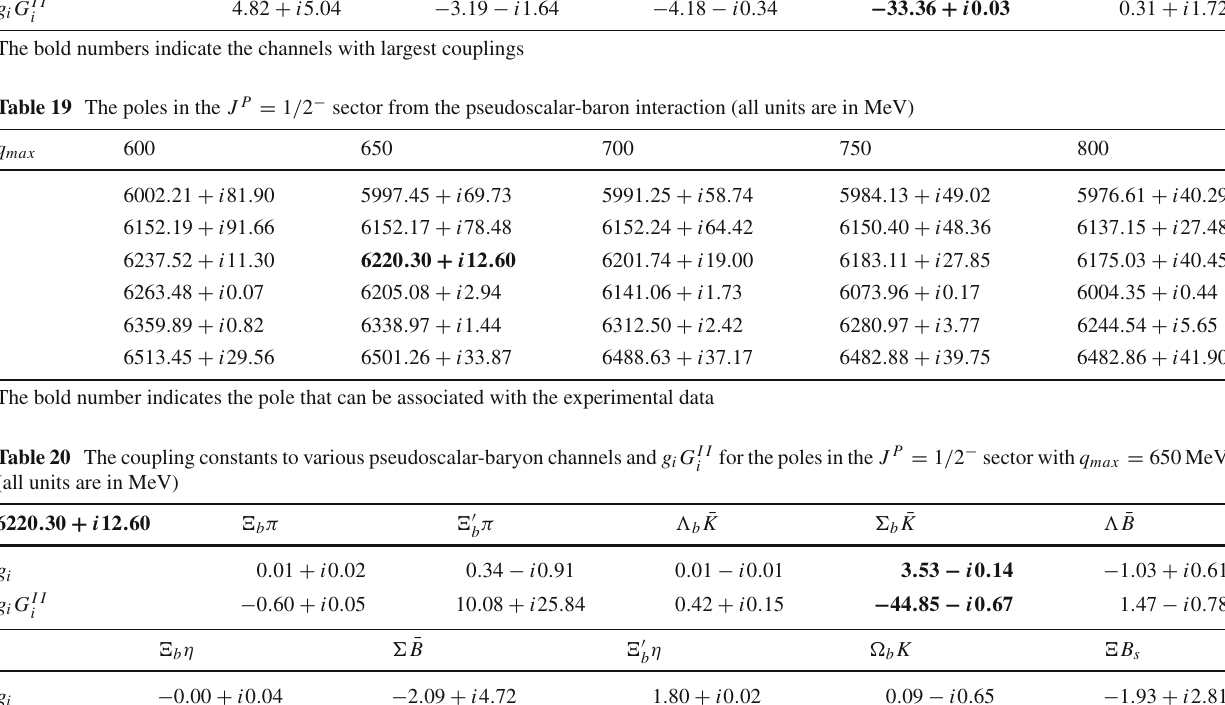
for the poles in the J P = 3 / 2 − sector with q max = 700MeV i